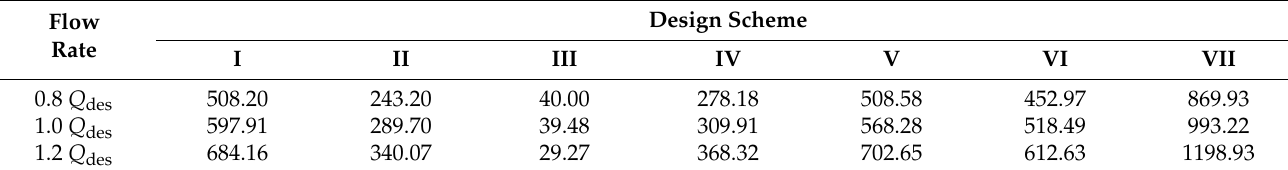
Figure 18. Frequency ‐ domain diagram of the radial force under 1.0 Q des conditions.